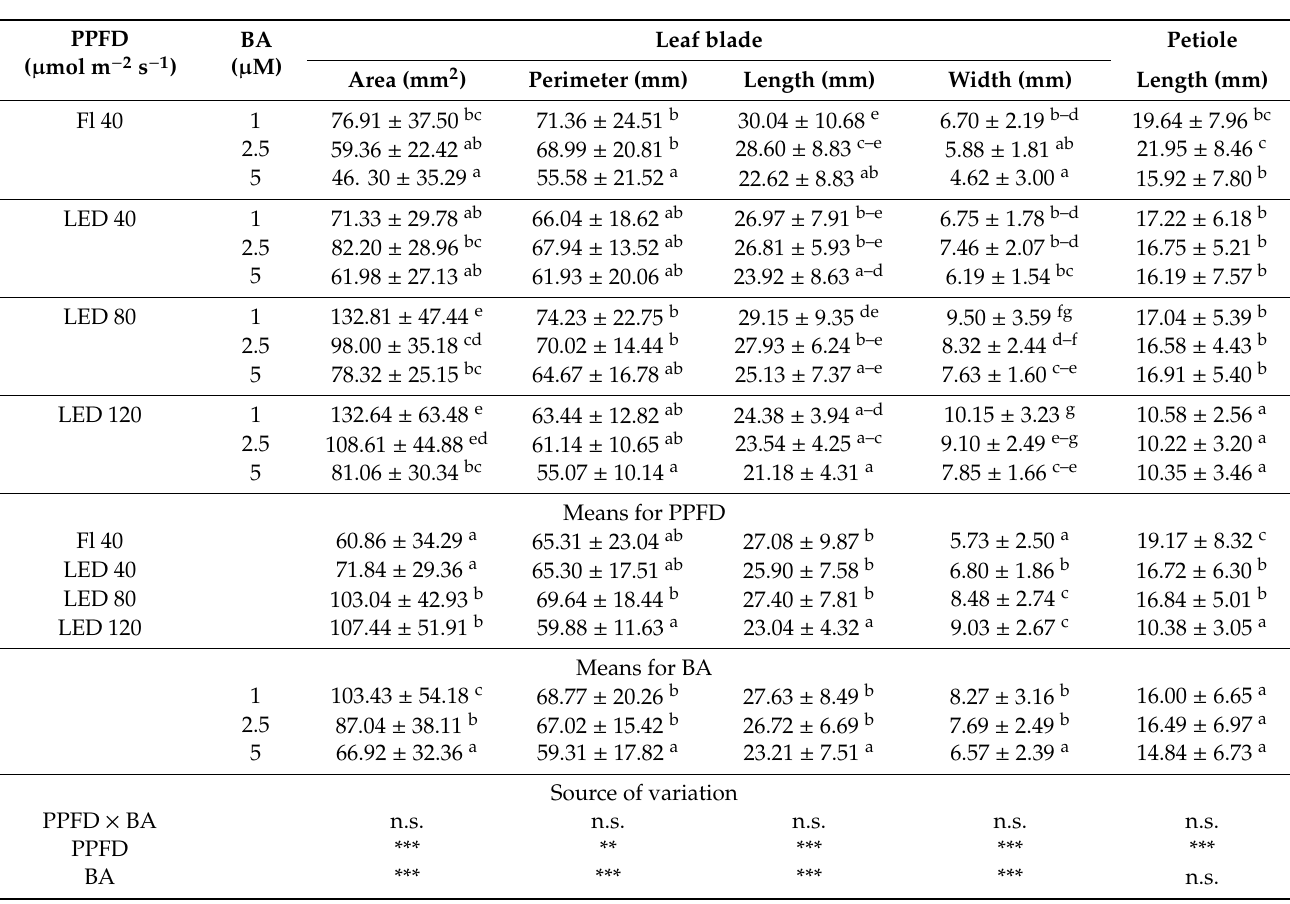
Table 2. Leaf morphometry of Gerbera jamesonii after six weeks of in vitro culture on Murashige and Skoog (MS) medium with various 6-benzyladenine (BA) concentrations and di ff erent photosynthetic photon flux densities PPFDs. Significant e ff ect: **, p ≤ 0.05; ***, p ≤ 0.01; n.s. not significant. Fl 40—control, fluorescence Philips TK-D 36W / 54 lamps. LED 40, LED 80, LED 120—combination of red (70%) and blue (30%) light emitted by light-emitting diodes with 40, 80 and 120 µ mol m − 2 s − 1 PPFD, respectively. Means ± standard deviations within a column followed by the same letter are not significantly di ff erent according to Duncan’s multiple range test at p ≤